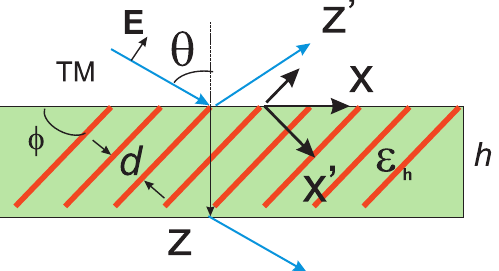
Figure 1. A sketch of amplifying graphene-based asymmetric hyperbolic metamaterial. Graphene sheets are orthogonal to the ( x (cid:48) z (cid:48) ) -plane and periodically arranged in the x (cid:48) -direction. h denotes the thickness of graphene